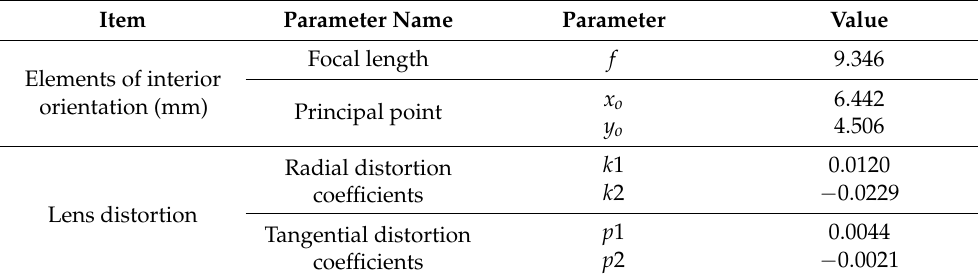
Table 2. Camera elements of interior orientation and lens distortion calculation